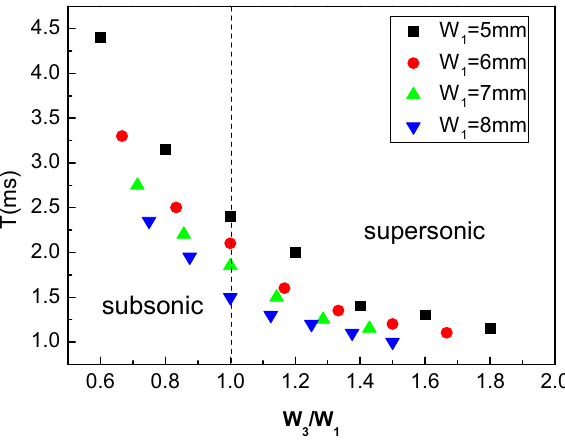
ff erent oscillator